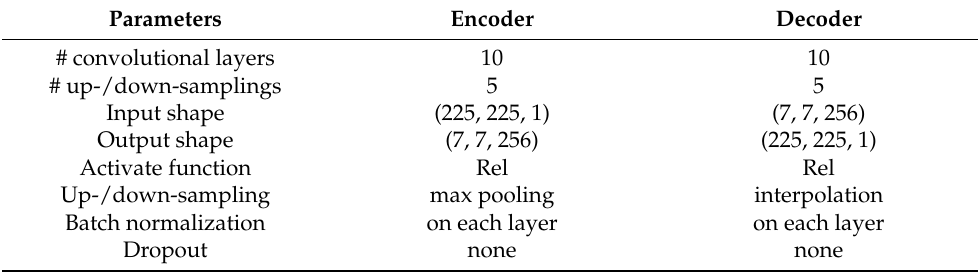
Table 1. Hyperparameters and detailed settings for convolutional